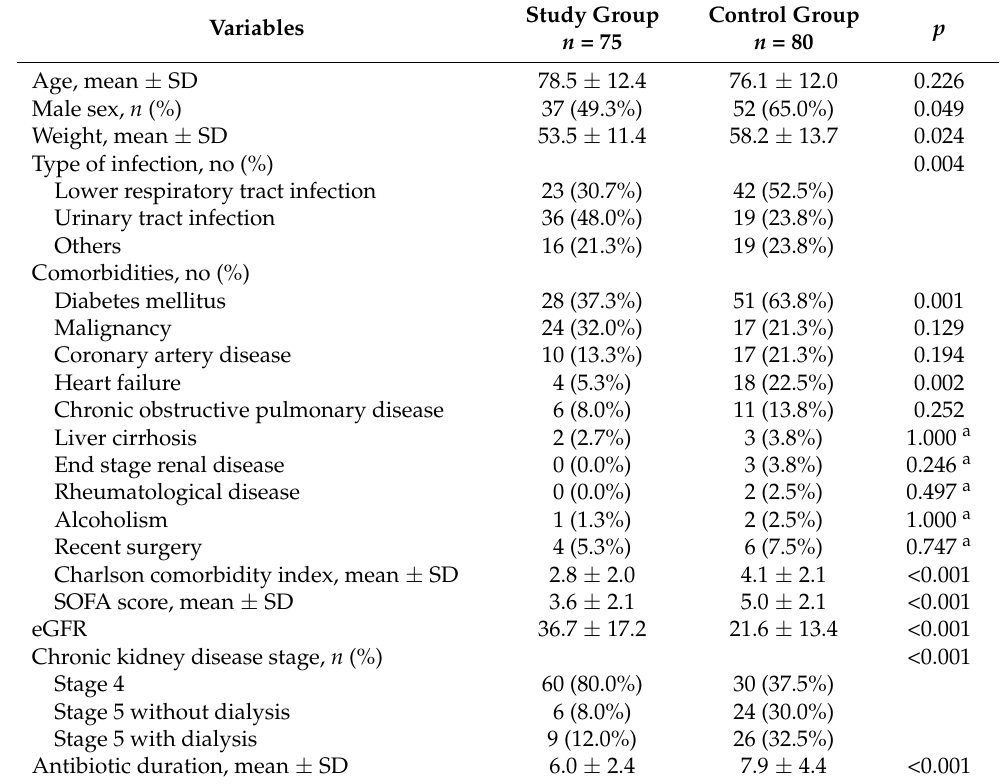
Table 1. The clinical characteristics of the